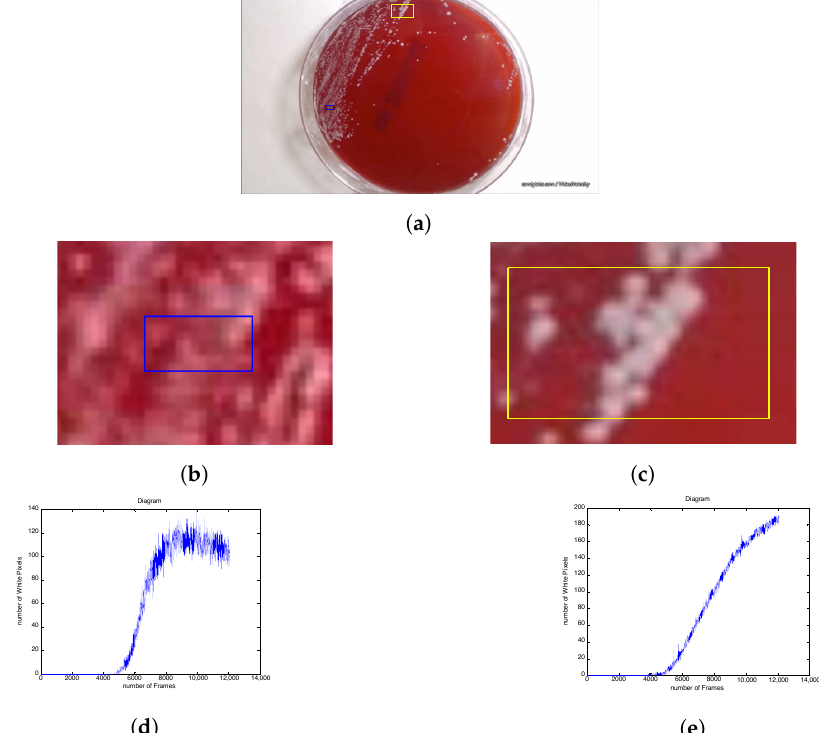
Figure 7. ( a ) The last snapshot of the petri dish, along with two selected areas containing many colonies, depicted in yellow and blue; ( b , c ) the selected areas of the plate magnified; ( d , e ) the corresponding experimental population curves of the blue and yellow areas,